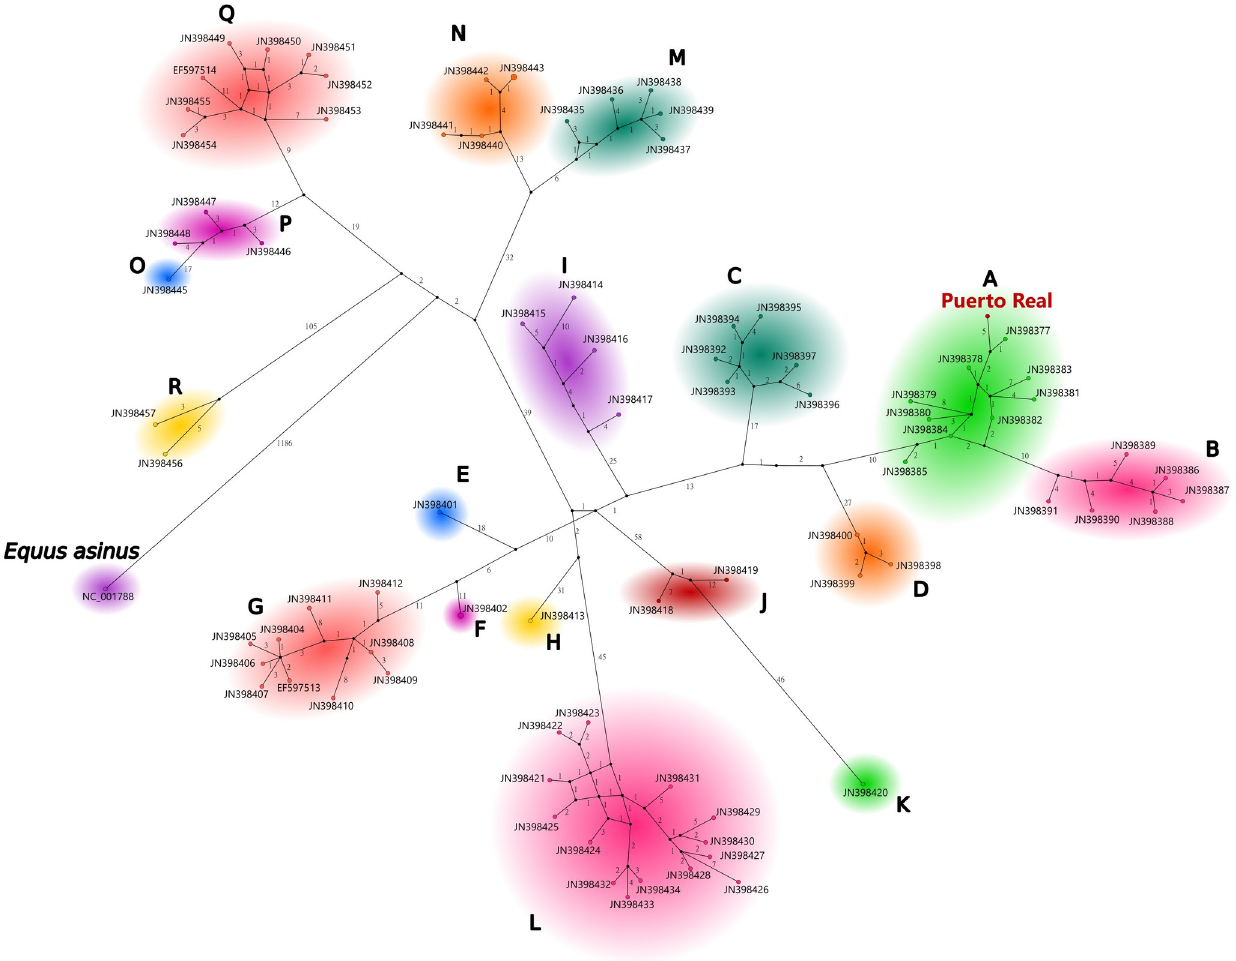
Fig 3. Median joining network of the 85 equid specimens (including Equus asinus as an outgroup and the Puerto Real horse). Numbers on the branches indicate the number of mutations separating each mitogenome.